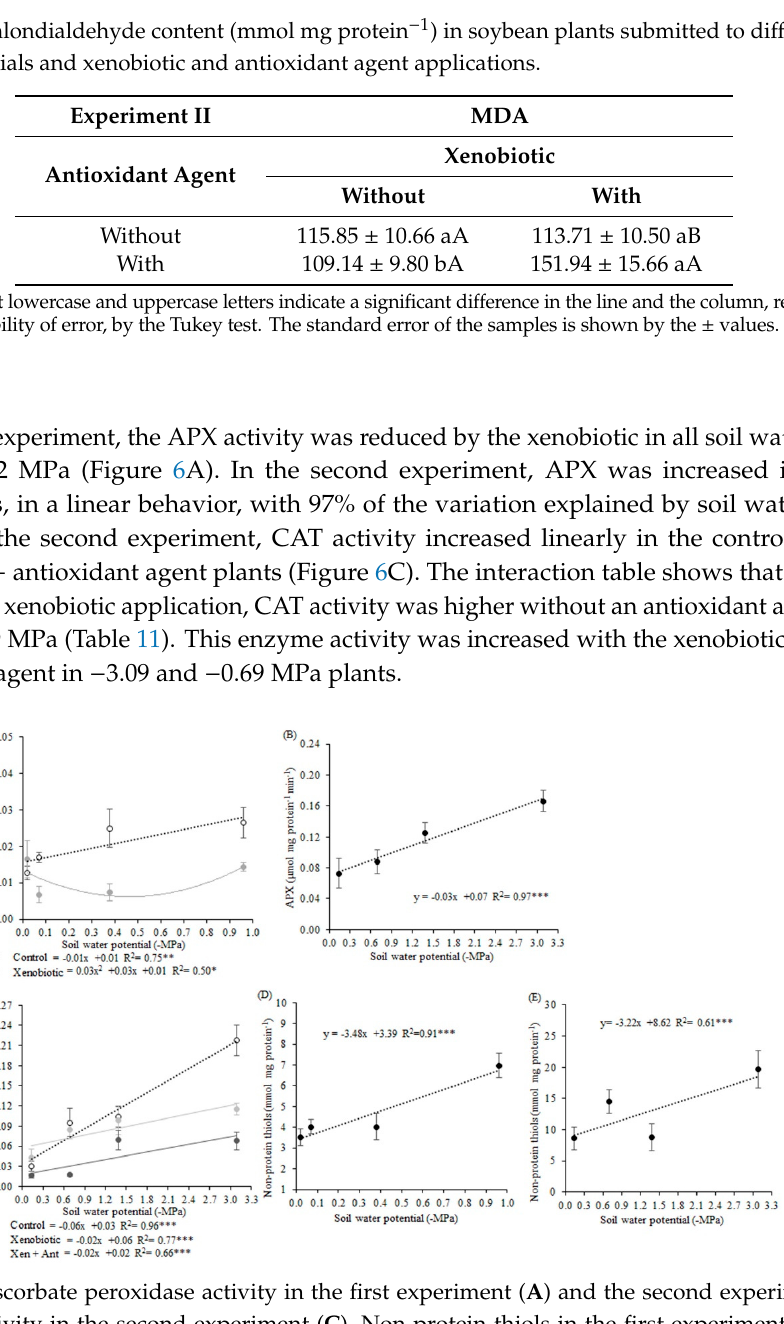
Table 10. Malondialdehyde content (mmol mg protein − 1 ) in soybean plants submitted to di ff erent soil water potentials and xenobiotic and antioxidant agent applications.